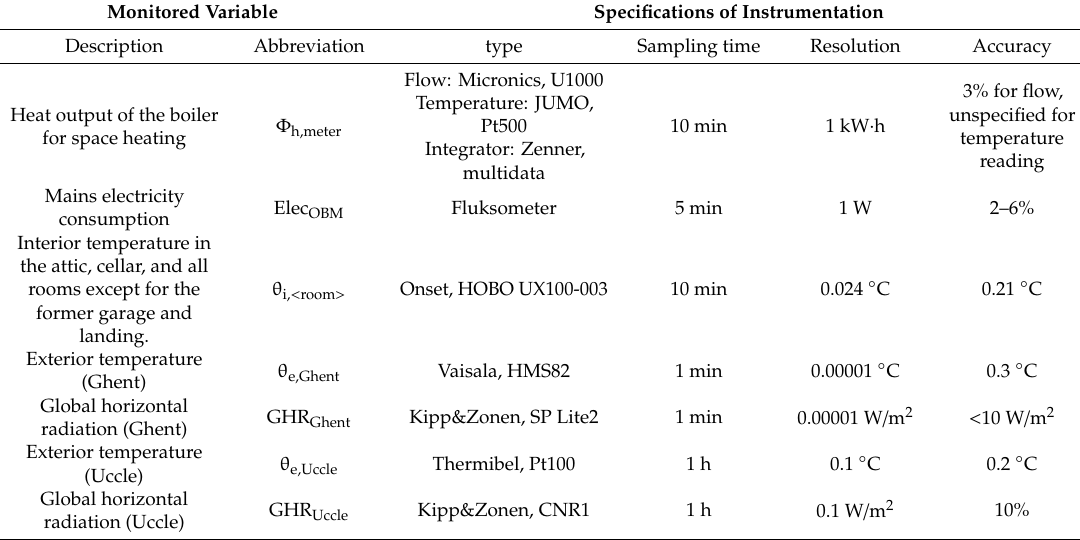
Table 2. Overview of the data collected during the on-board monitoring (OBM) campaign, as well as specifications of the instrumentation